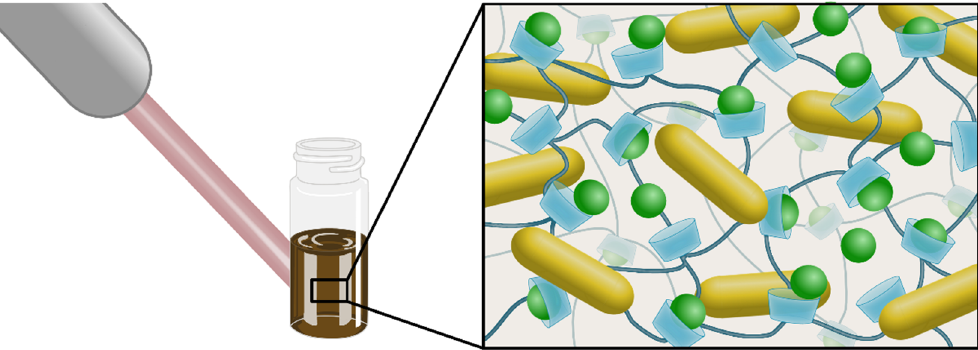
Figure 1. Schematic representation of the NSs–drug complexes associated with AuNRs. Laser light stimuli of 1064 nm is absorbed by AuNRs and transformed into local heat, which induces the release of MPH and CUR (represented in green circles) from the cavities of NSs.